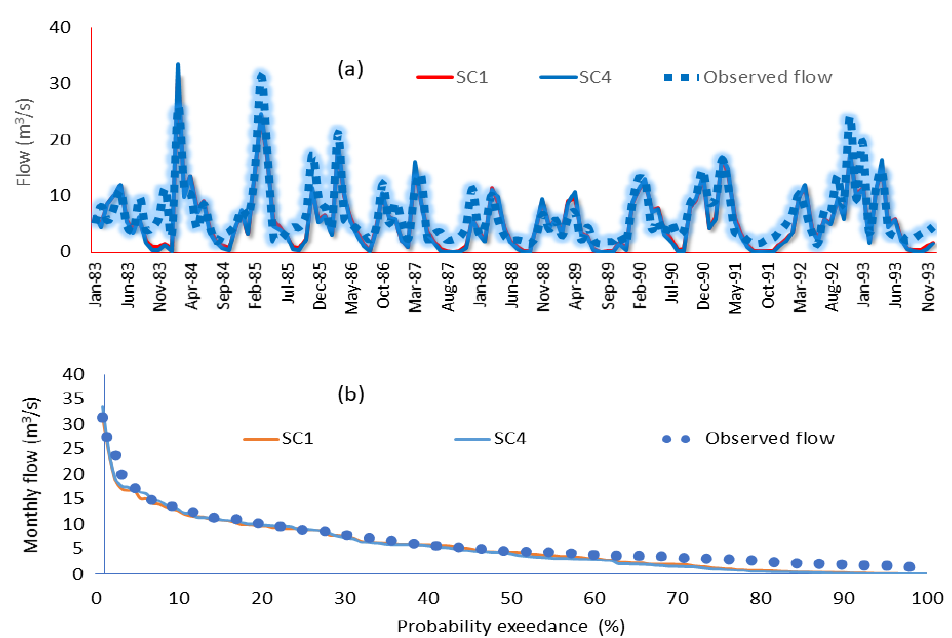
Figure 8. Comparison of simulated temporal streamflow scenarios (SC1 and SC4) with observed data at Ingresol station (T1). ( a ) Monthly time series plot for the time period of 1983 to 1993. ( b ) Flow duration curve (FDC) at station T1.